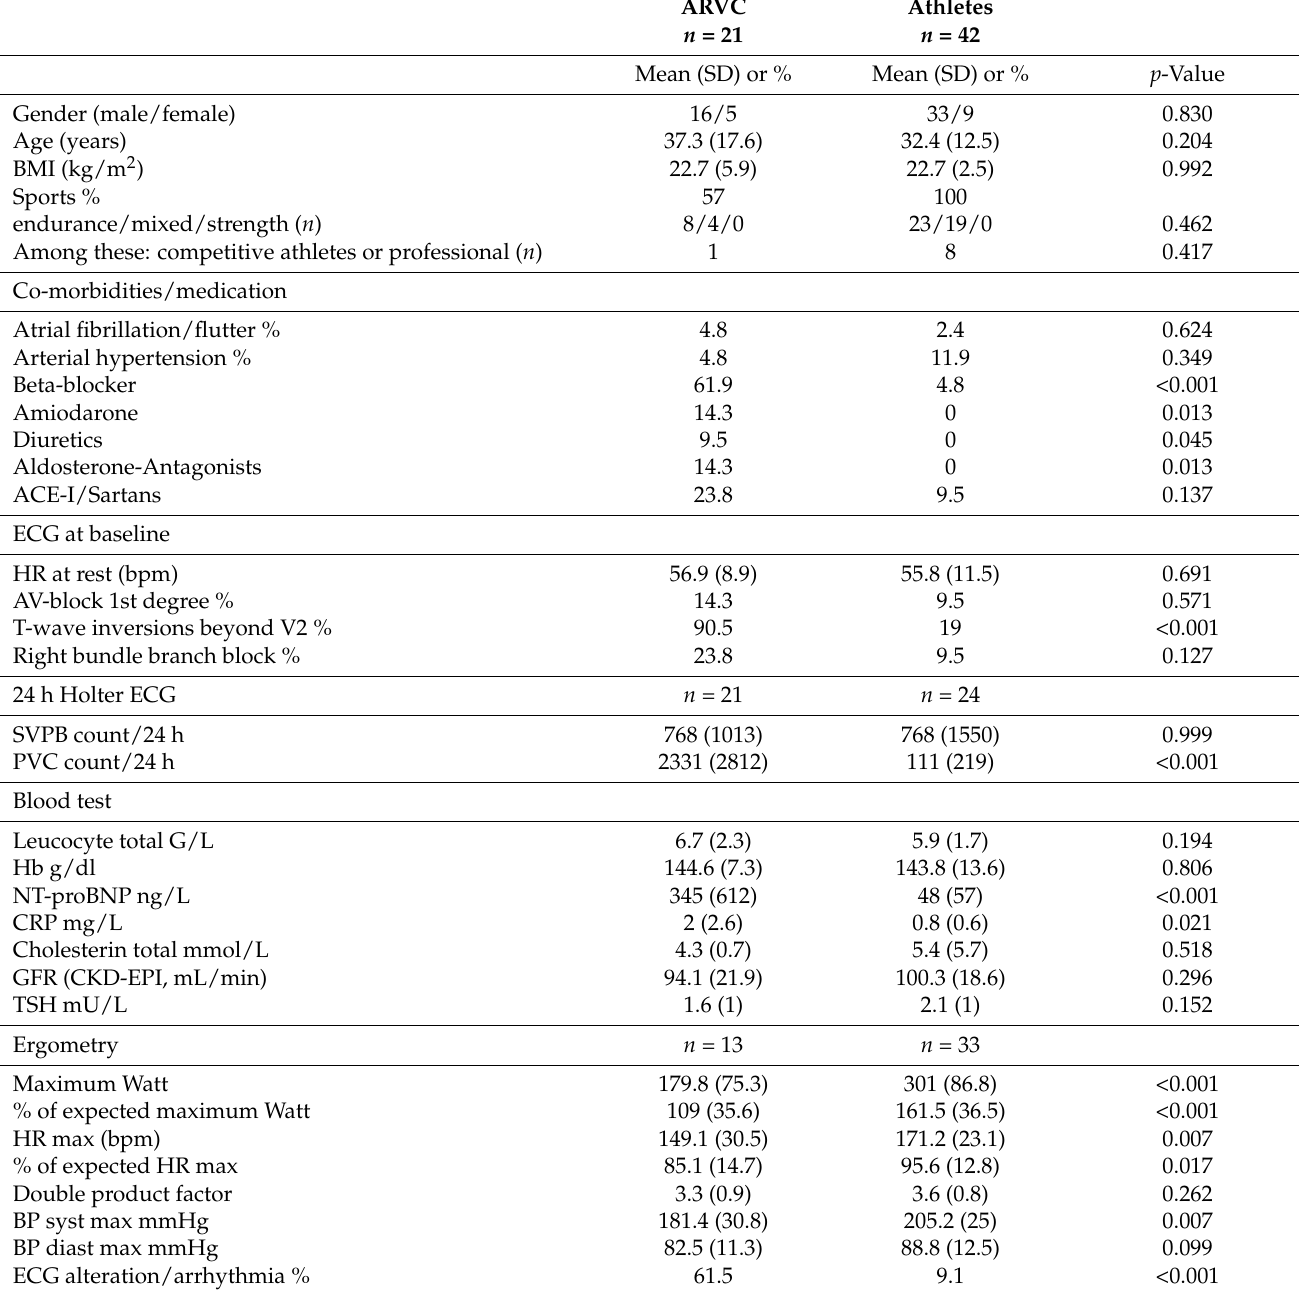
Table 1. Baseline characteristics of ARVC patients vs.